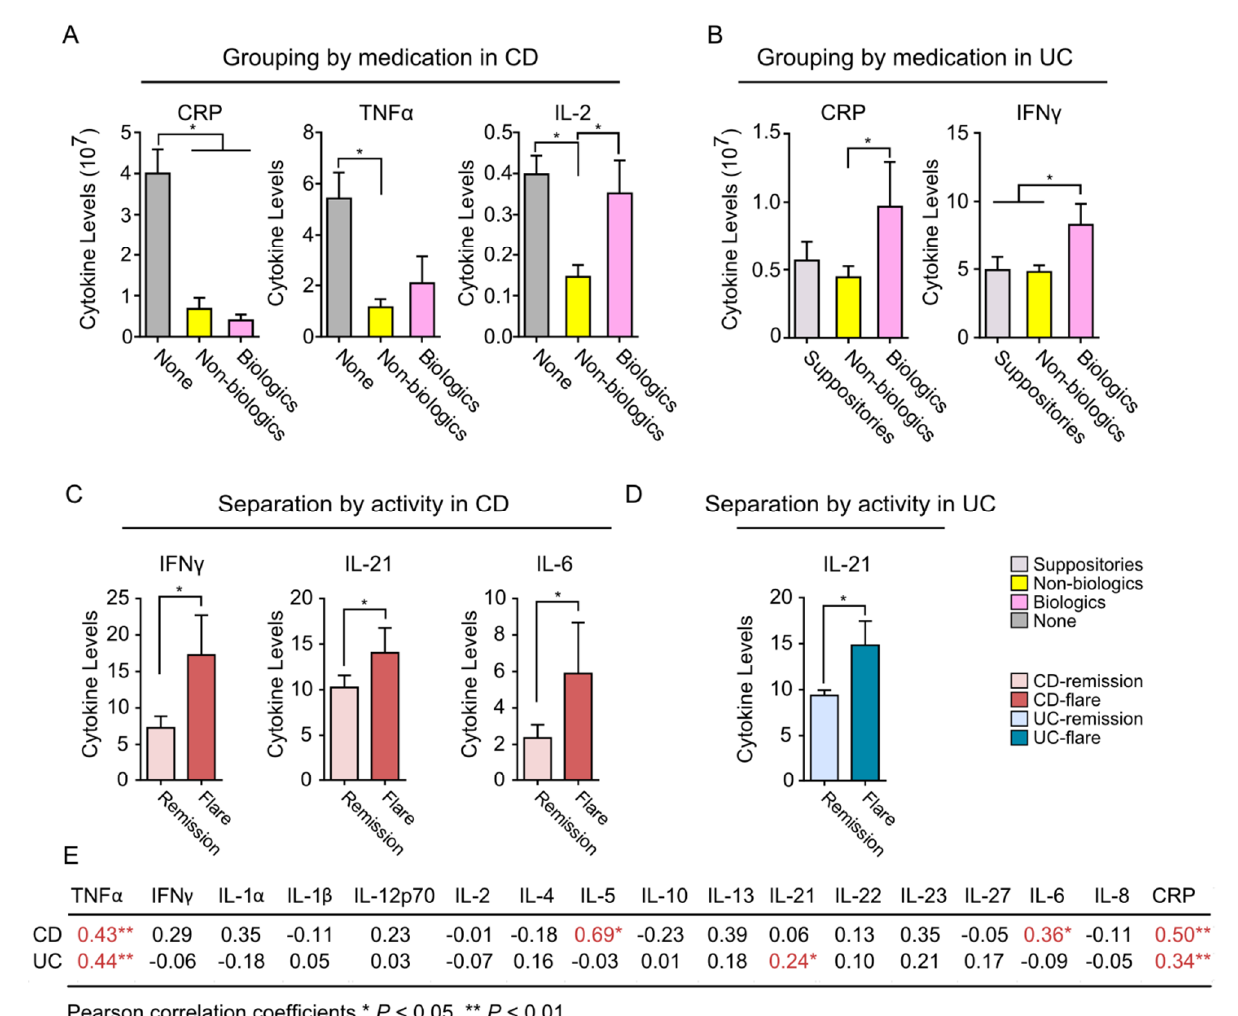
Figure 4. Maternal serum cytokines by medication use and active flare-up during pregnancy. ( A ) Maternal CRP, TNFα, and IL-2 differ by medication use in women with CD during pregnancy (N = 8–14 patients per group). ( B ) CRP and IFN-γ differ by medication use in women with UC (N = 7–22 patients per group). ( C ) IFN-γ, IL-21, and IL-6 are increased with active disease in women with CD (N = 29), whereas ( D ) only IL-21 was increased with active disease in women with UC during pregnancy. ( E ) Table illustrating the Pearson correlations between active disease (measured using either FCP or CRP cut-offs) and serum cytokines in women with IBD. Numbers represent Pearson correlation coefficients, * denotes p < 0.05, and ** denotes p < 0.01.